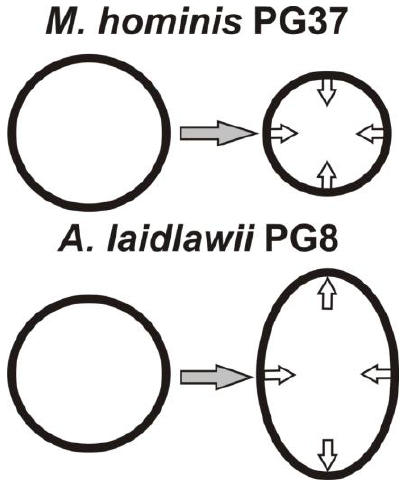
FIGURE 2. Scheme of the detected changes in DNA molecules of M. hominis PG37 and A. laidlawii PG8. Note : circles at the left side of the image are schematic illustrations of cross- sections of DNA molecules from the indicated bacteria grown in normal conditions (the vegetative forms). Arrows indicate changes observable in DNA isolated from VBNC forms of the corresponding mycoplasma cells. In M. hominis PG37, we detected “compression” of DNA: reductions in height and width of the molecule (the small circle at the upper right part of the image). In A. laidlawii PG8, we detected reduction in width, but increasing height of DNA (oval at the lower right part of the